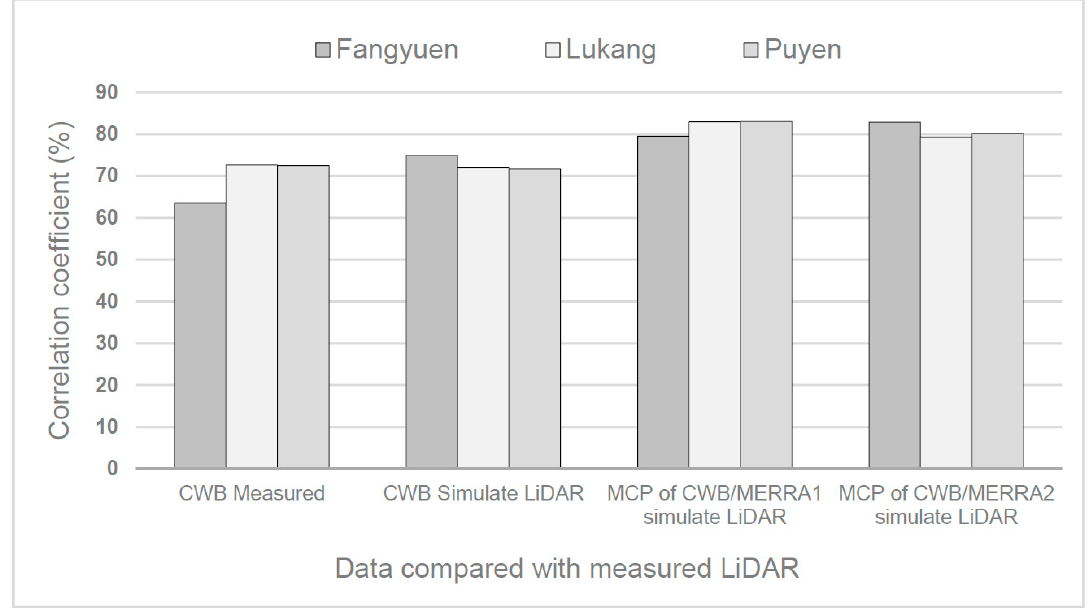
Figure 6. Correlation coefficient of wind speed data for (from left to right) measured floating LiDAR data and measured Central Weather Bureau (CWB) data, floating LiDAR data simulated using CWB data, floating LiDAR data simulated through measure, correlate, predict (MCP) using CWB data and MERRA location 1 data, and floating LiDAR data simulated through MCP using CWB data and MERRA location 2 data. Table 7. Correlation and RMSE of the wind speed for measured floating LiDAR data and floating LiDAR data simulated through MCP by using CWB data and MERRA data.